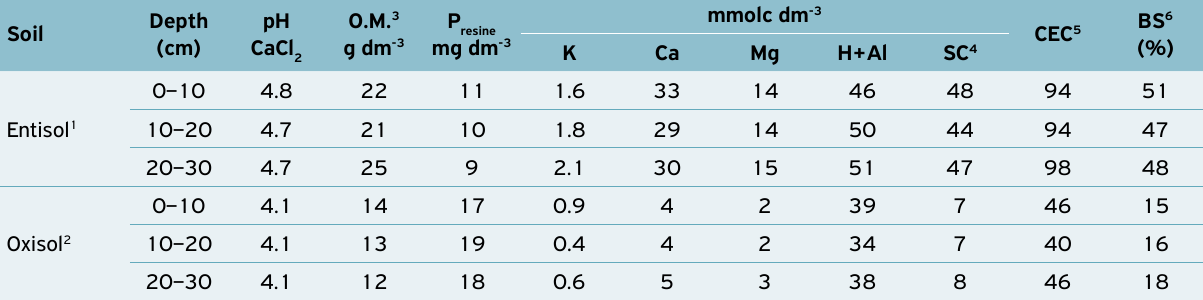
Table 1. Chemical analysis results of the soil samples collected from different depths in both experiments after the application of tebuthiuron. Botucatu, São Paulo, 2013.